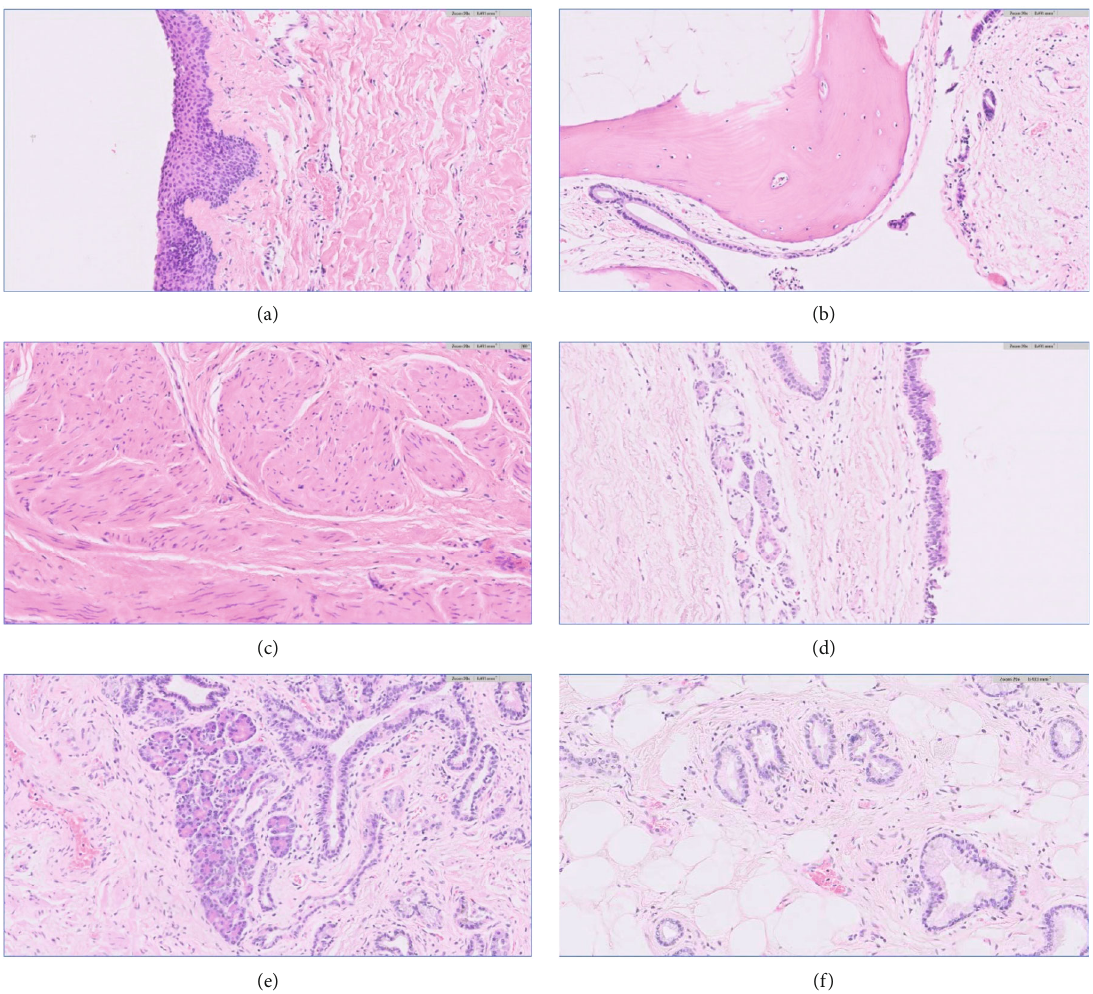
Figure 2: Microscopic examination of the cyst wall revealing squamous epithelium (a), mature bone (b), smooth muscle (c), respiratory epithelium (d), pancreatic tissue (e), and enteric epithelium